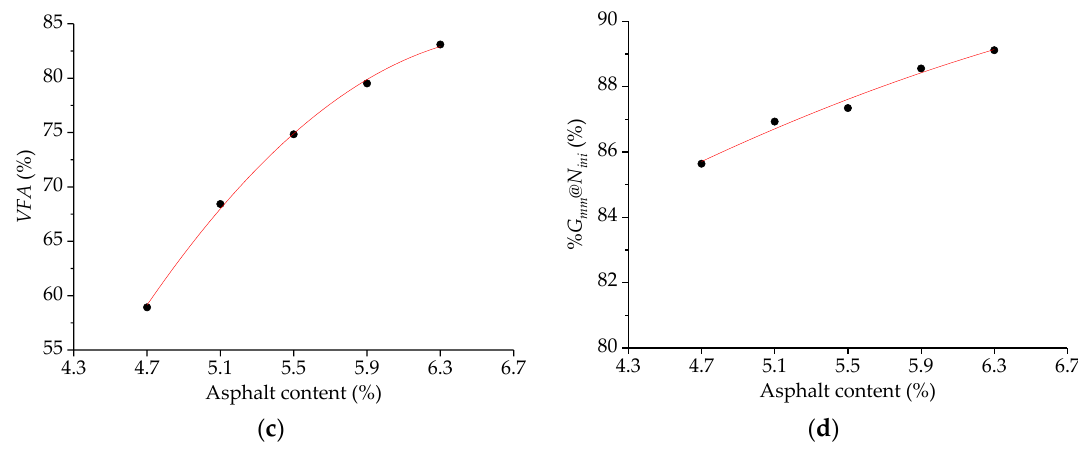
Figure 9. The Superpave mix design results of asphalt mixture with basalt fiber: ( a ) VA , ( b ) VMA , ( c ) VFA , and ( d ) % G mm @N ini .